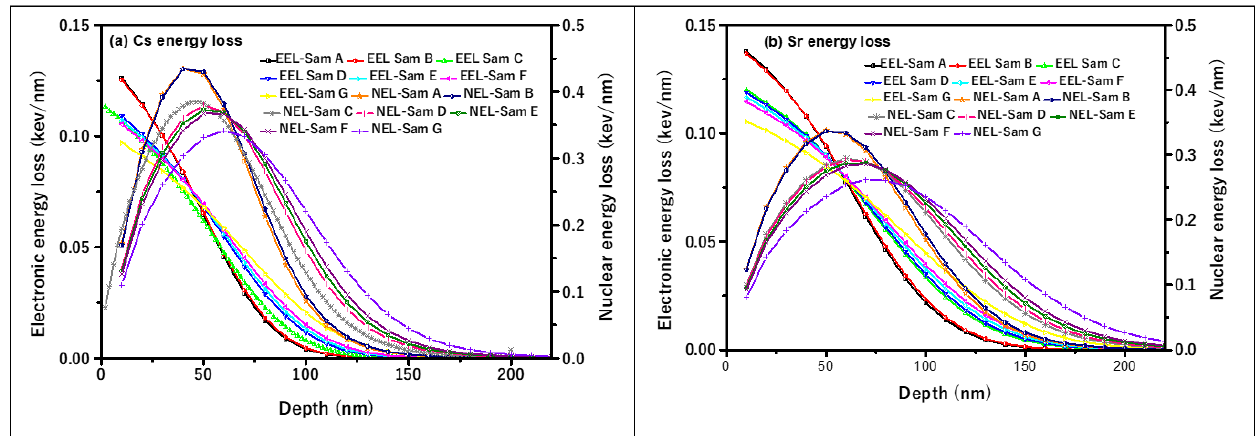
Figure 9. Predicted energy loss of ( a ) Cs and ( b ) Sr ions in the different clay samples. For the understanding of legends in Figure 4a,b, EEL-Sam A:electronic energy loss in sample A; NEL:Nuclear energy loss in sample A, etc .